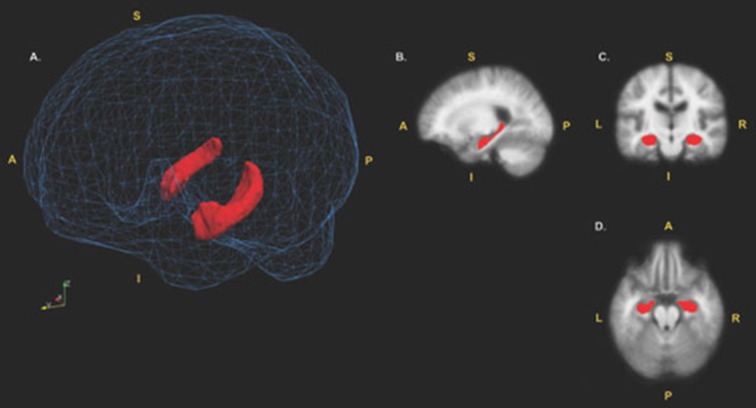
Hippocampal region of interest (ROI). (A) surface models of the left and right hippocampi ROIs displayed in red. The hippocampi are visualized inside a wireframe mesh provided by Madan (2015). (B) Sagittal view (x = 105), (C) coronal view (z = 110) and (D) axial view (y = 151) of the hippocampi displayed in red. Coordinates are in MNI305 space. A, Anterior; P, Posterior; I, Inferior; S, Superior.